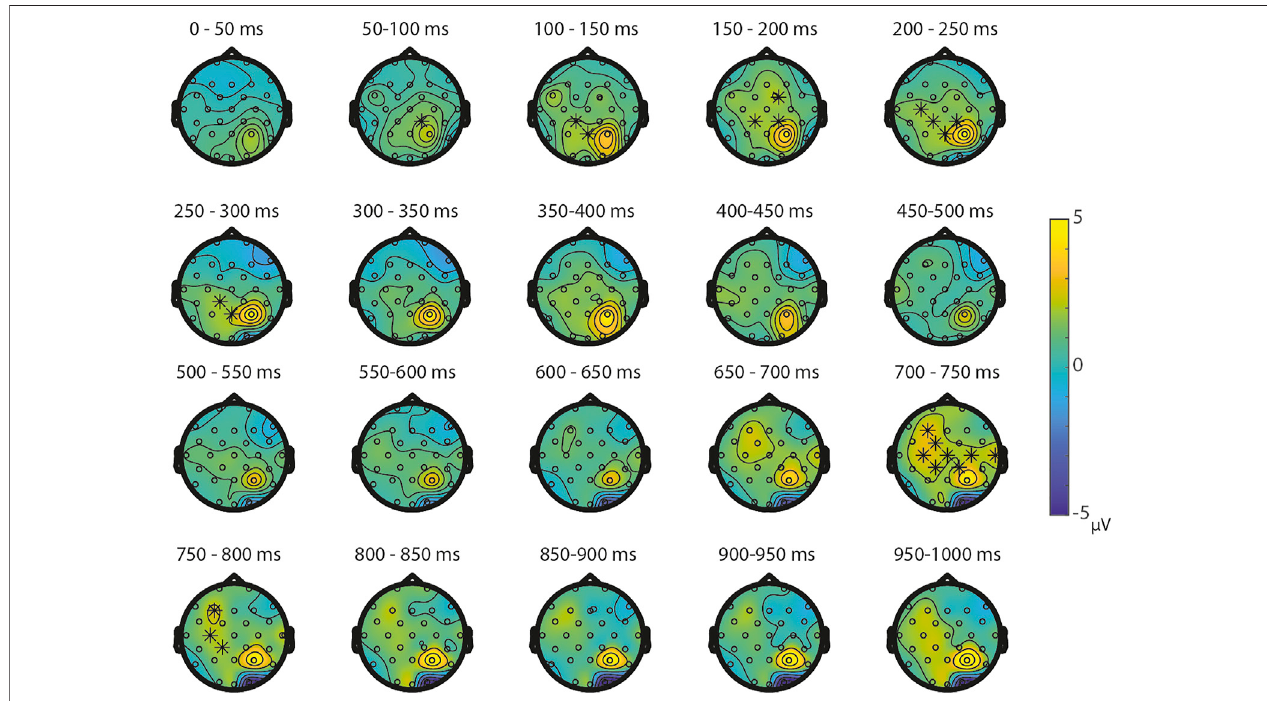
FIGURE 4 | Topoplots of the differences between the ratio ’ s in the SS-task per time window with asterisks representing the signi fi cant differences between the ratios based on α (cid:1)